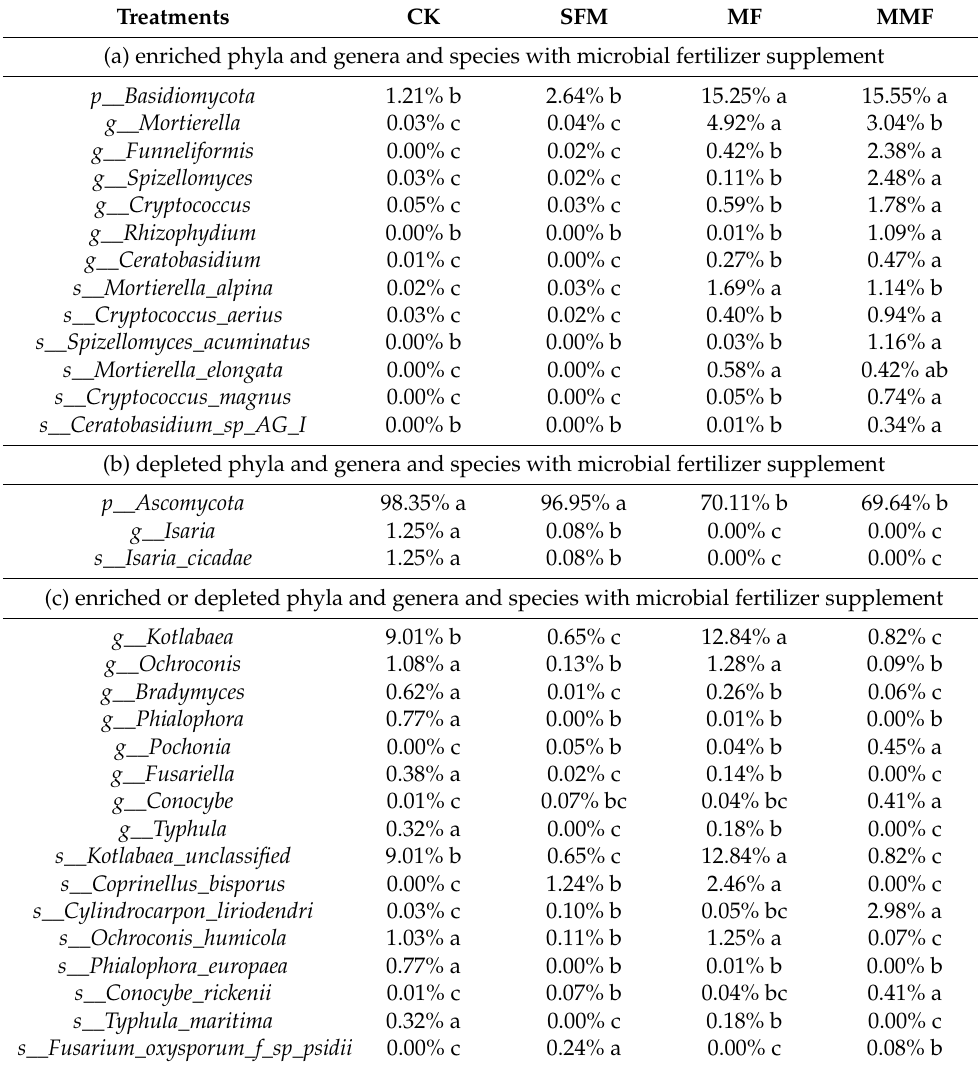
Table 2. The fungal group significantly changed ( p < 0.05) total reads of Lanzhou lily rhizosphere soil from Illumina NovaSeq data (the phyla with average RA > 5%, and the genera with average relative abundance > 0.1% and the species with average relative abundance > 0.05%; the accession number is ID PRJNA805390): the significance is 0.05 for lower letters (a, b, c) presented in table.